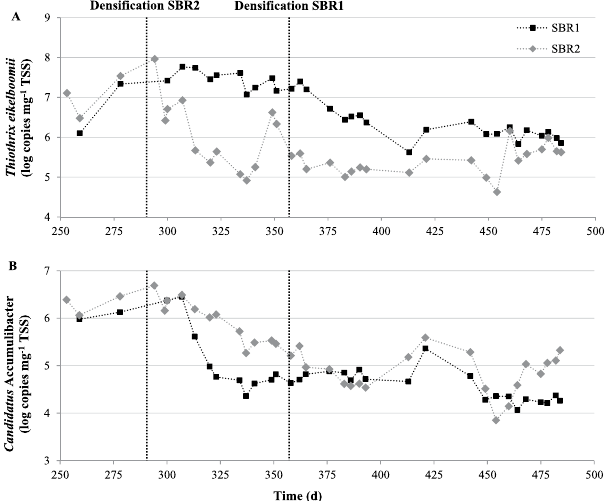
Figure 5. Temporal change in the concentration of Thiothrix eikelboomii ( A ) and Candidatus Accumulibacter ( B ) expressed in number of copies of 16S rRNA operon per mg TSS, in SBR1 and SBR2 from day 250 to 500. Densification strategy (Strategy III) was applied from day 283 on SBR2 and from day 358 on